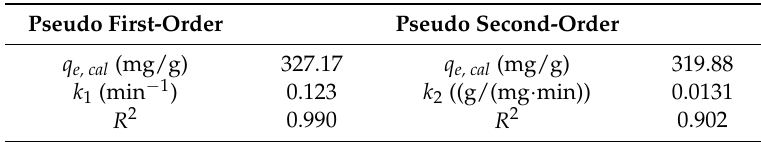
Table 3. Parameters of the pseudo first and second-order kinetic models for the adsorption of Cr(VI) on MFNNs. Pseudo